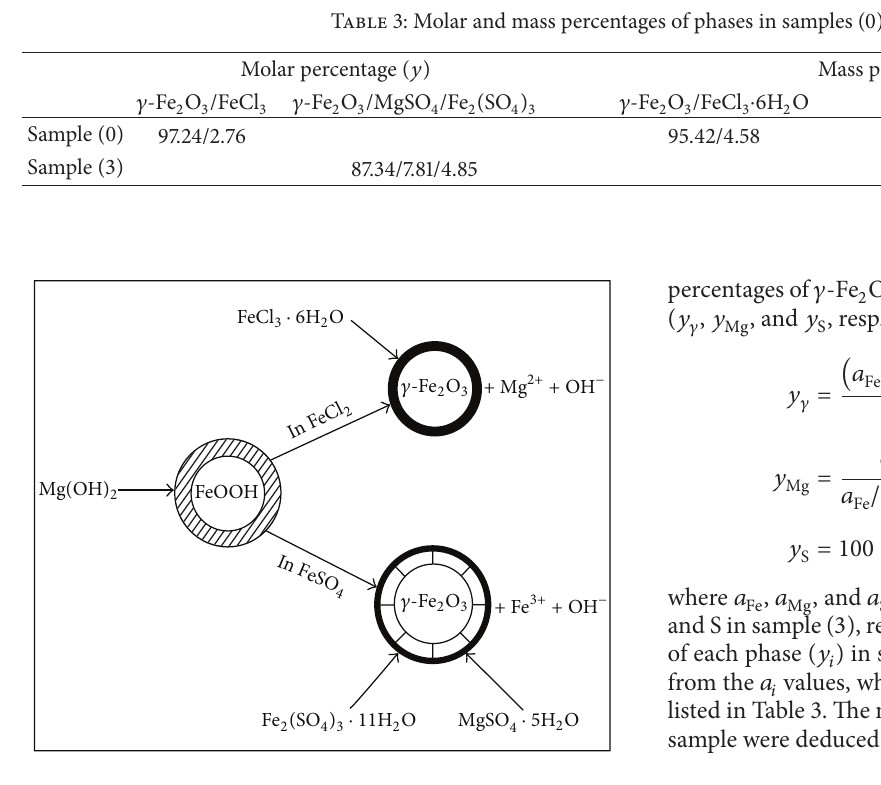
Figure6:Schematicdiagramoftheformationofmagneticnanopar- ticles using FeCl 2 and FeSO 4